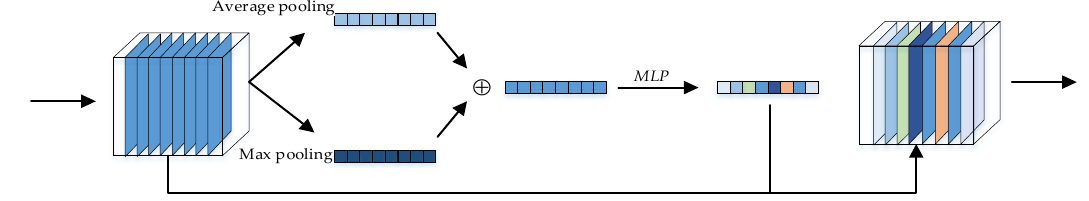
Figure 6. The channel attention module.